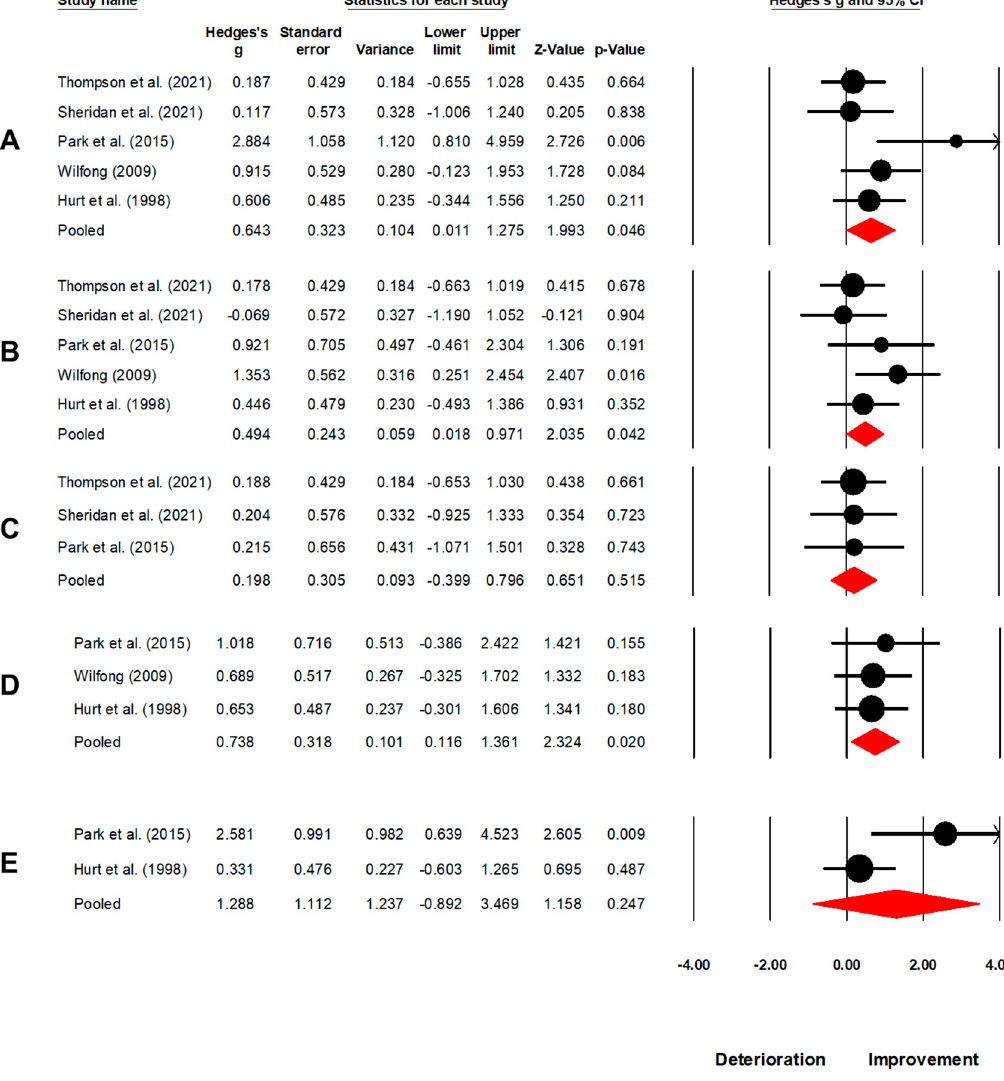
Figure 5. A forest plot depicts the impact of MT on ( A ) gait speed, ( B ) cadence, ( C ) step length, ( D ) stride length, and ( E ) gait symmetry in individuals with TBI. It includes individual weighted effect size Hedge’s g represented as black circles, and the whiskers represent the 95% confidence intervals. The pooled weighted effect size and 95% CI are presented at the bottom with a red diamond. A positive overall effect size in this analysis implies an enhancement in spatiotemporal outcomes of gait with MT, while a negative overall effect indicates a decline in spatiotemporal outcomes of gait with MT. Refs [16,62,63,65,77] mentioned.